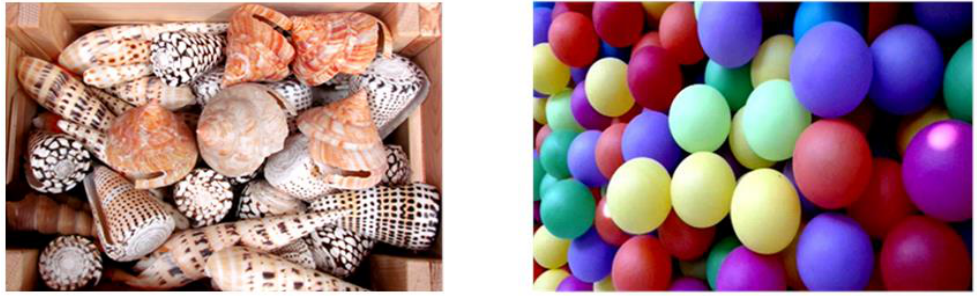
Figure 1. Chiral ( left ) and achiral ( right ) macroscopic objects.